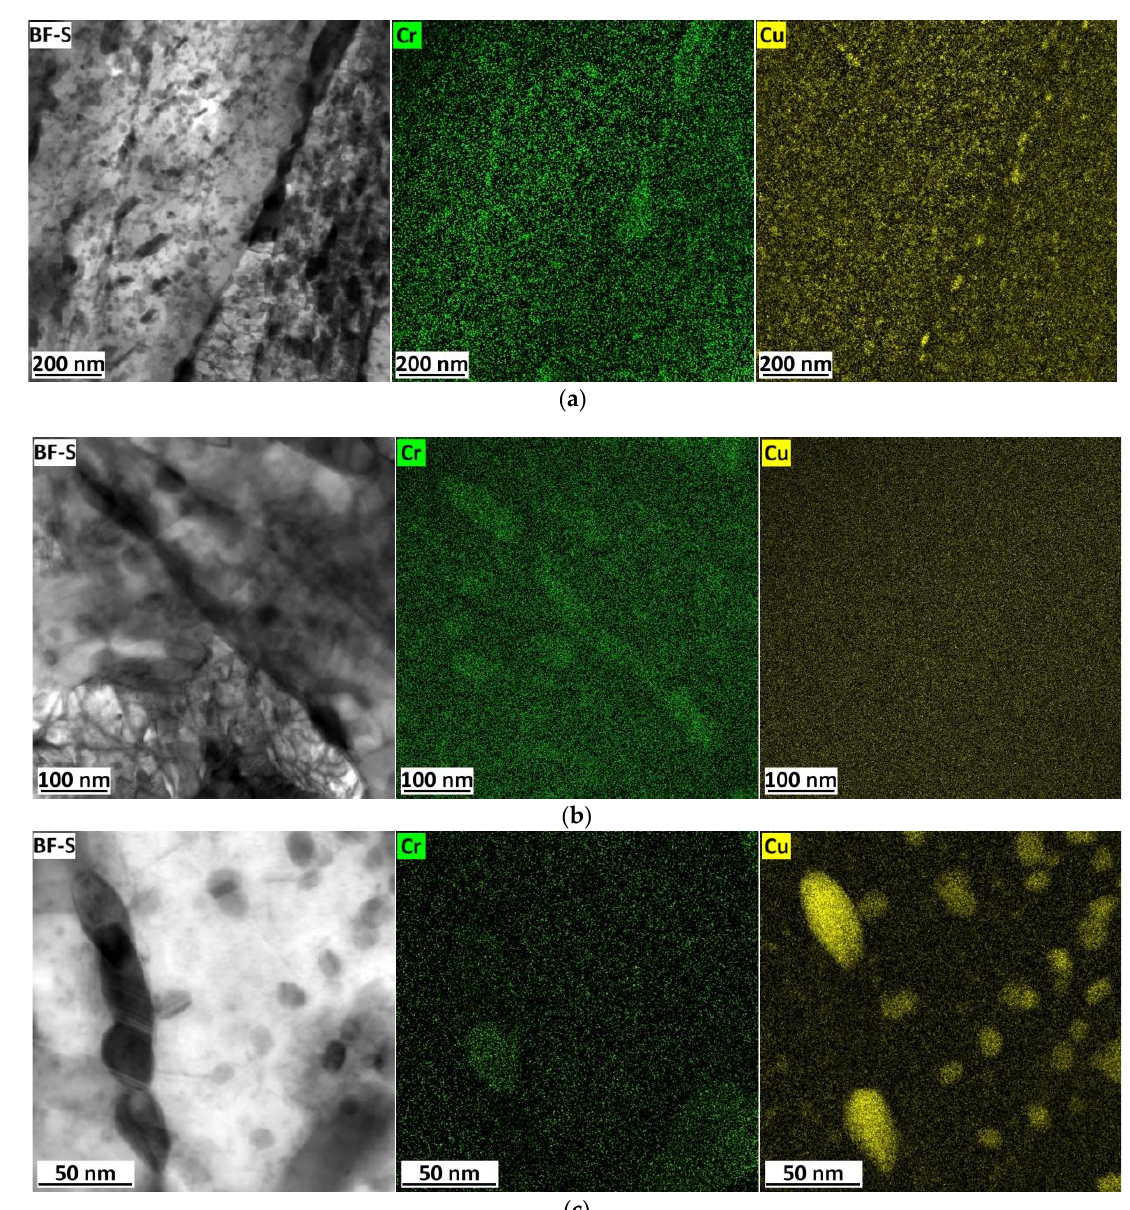
Figure 6. Precipitates in 1.5 Cu and 0 Cu samples tempered at 500 °C for 24 h (green coloured Cr map represents cementite particles, and the yellow colour represents EDS maps of Cu precipitates): Cu precipitates precipitated at martensitic needles boundary in the sample 1.0 Cu ( a ); martensitic needle boundary occupied by cementite in sample 0 Cu ( b ); and Cu precipitates formed at the edge of cementite inside the martensitic needle in the microstructure of 1.5 Cu tempered at 500 °C for 48 h ( c ).